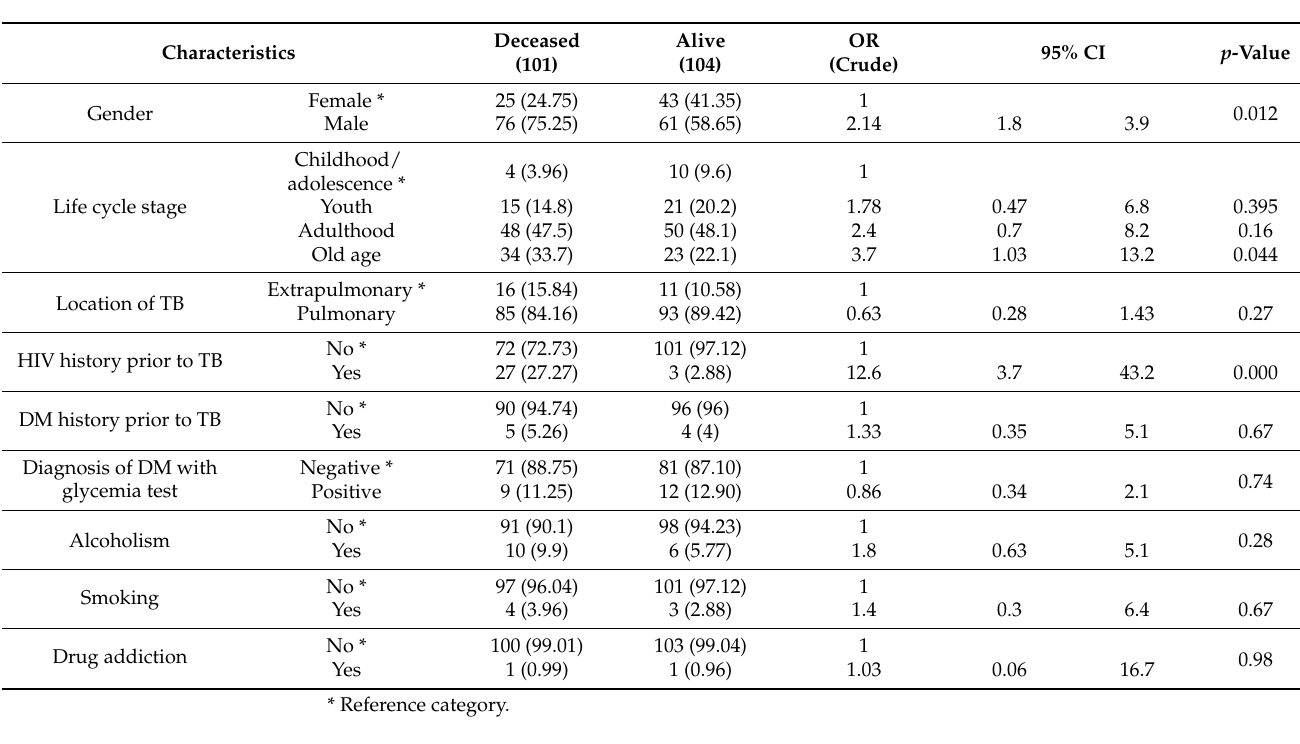
Table 3. Association between mortality and sociodemographic and clinical factors of the indigenous community diagnosed with sensitive TB 2015–2019.